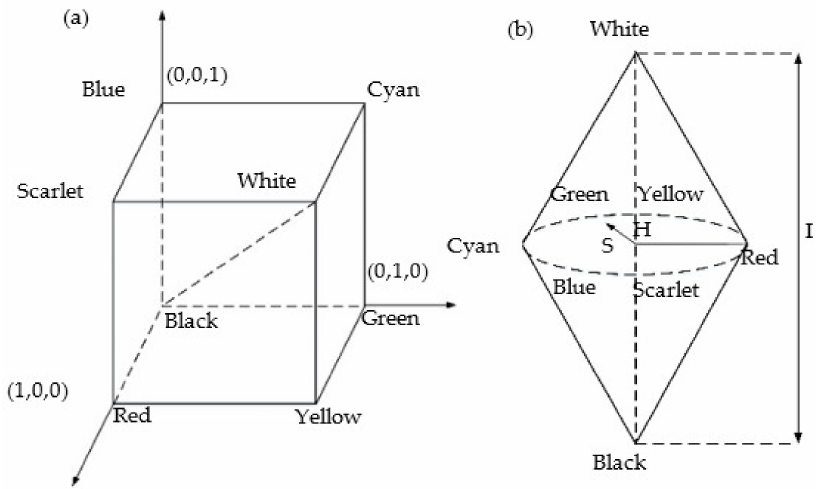
Figure 8. Principle of color conversion algorithm: ( a ) RGB space; ( b ) HSI